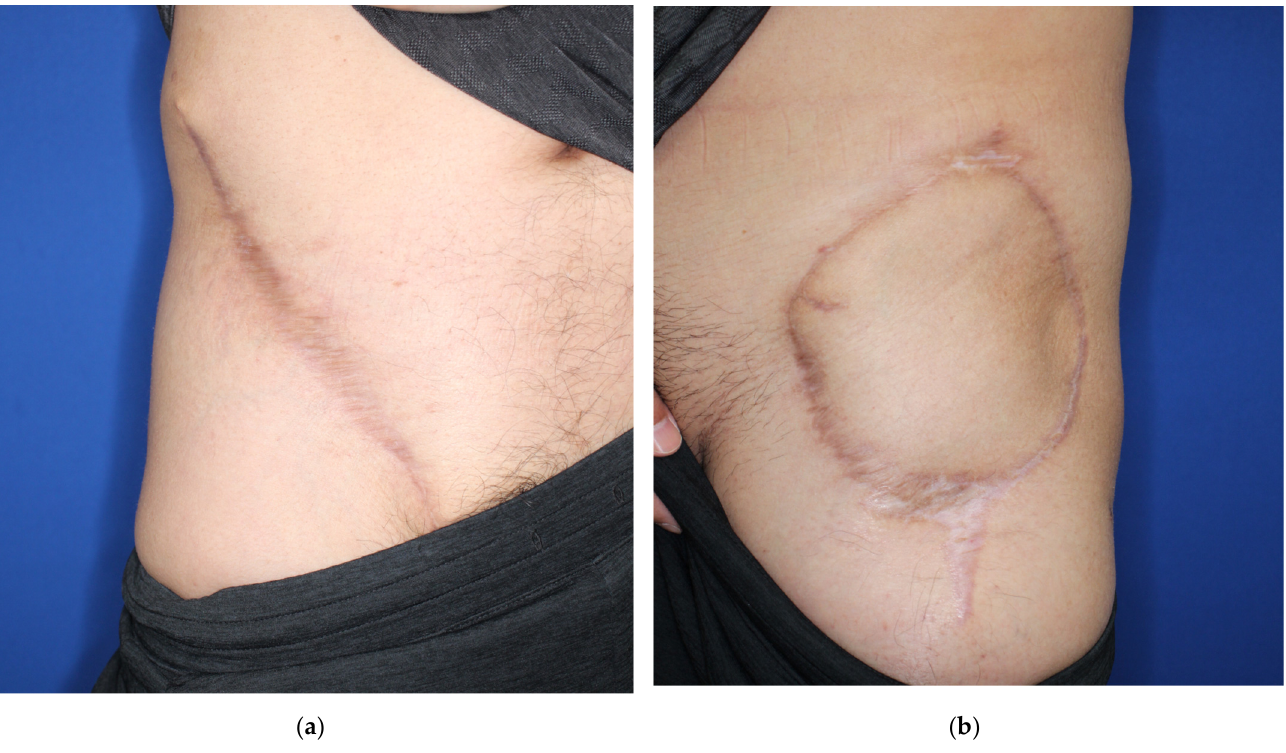
Figure 5. The postoperative photos at a one-year follow-up. ( a ) The donor site healed without complications; ( b ) the flap survived.